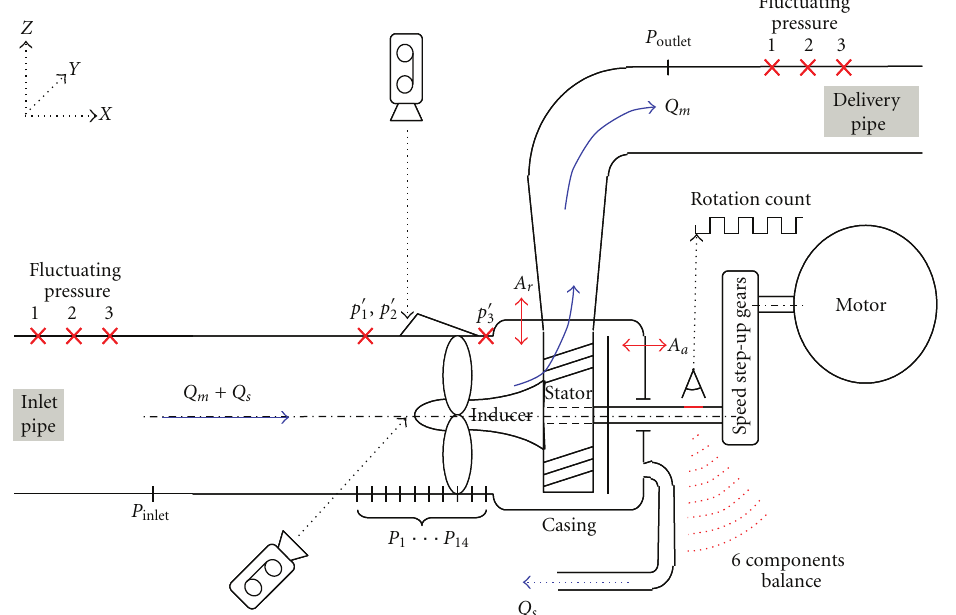
Figure 4: Scheme of the inducer test section including the acquisition